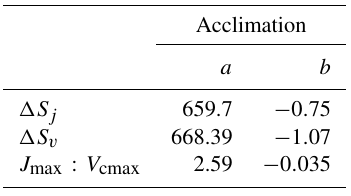
Table 4. Parameter values derived by Kattge and Knorr (2007) and used in this study in Eq. (10) to model thermal acclimation of pho- tosynthesis using the AcKK